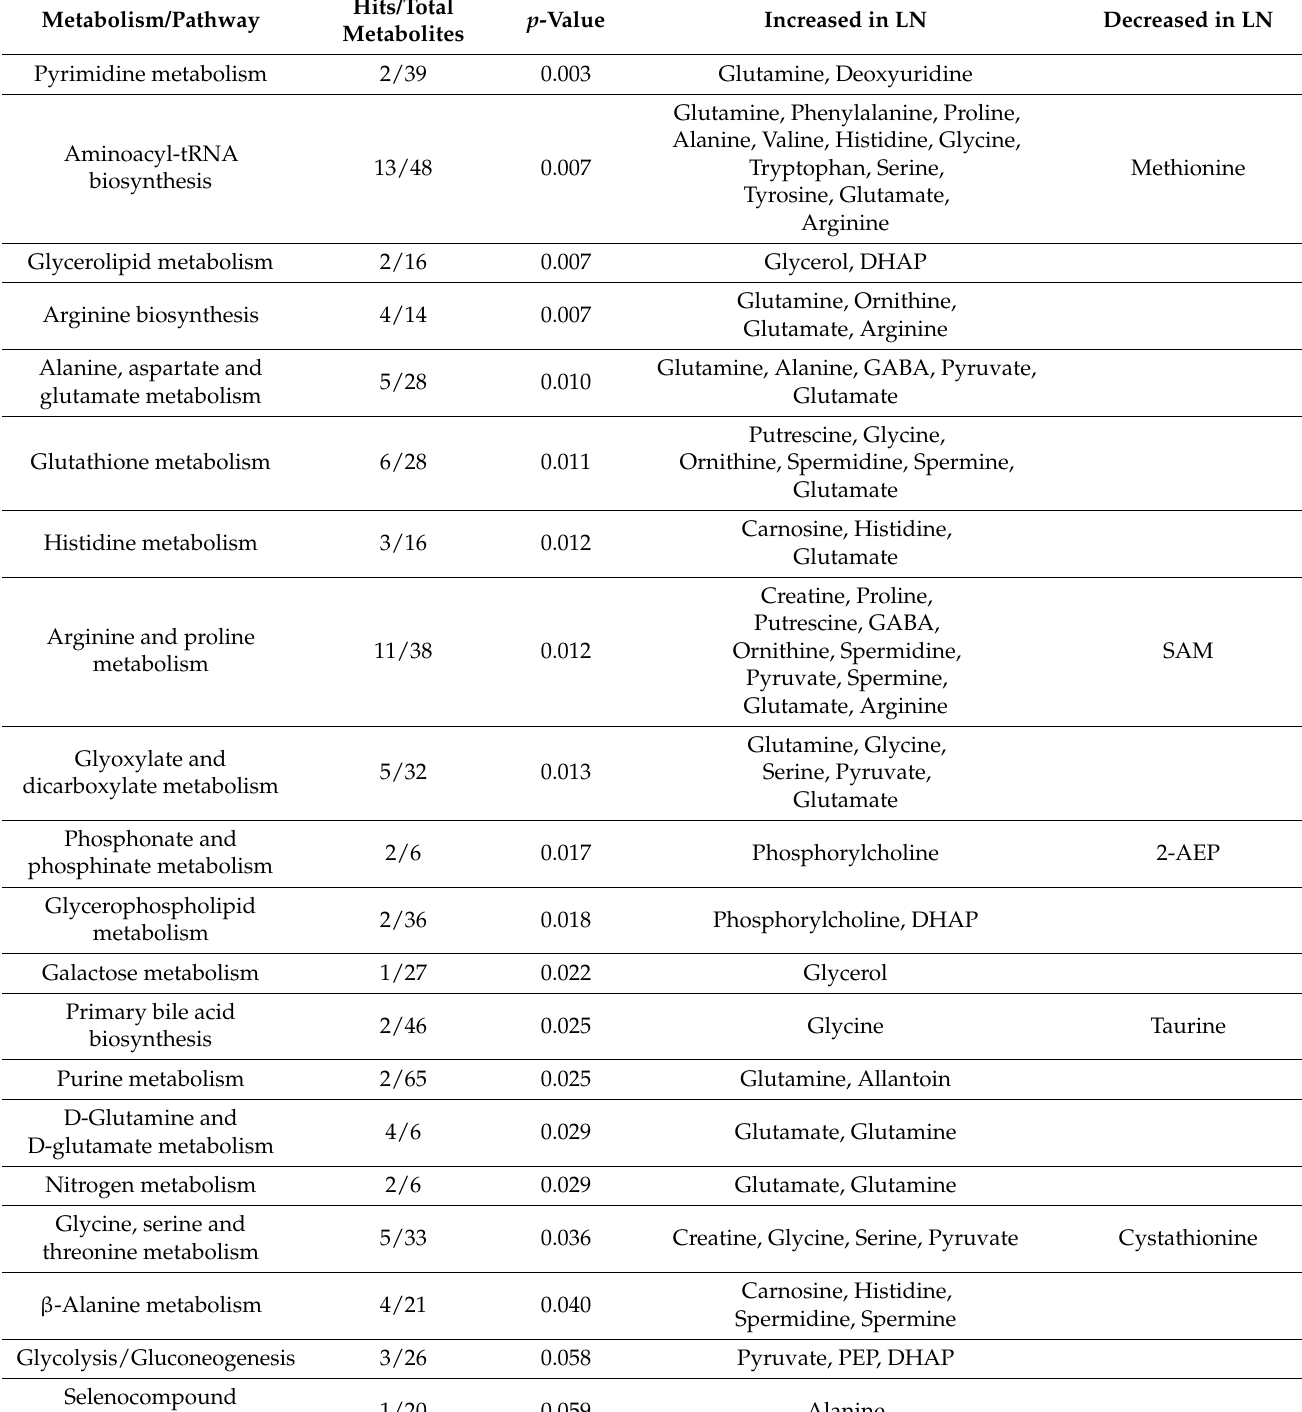
Table 3. Top 20 fetal muscle metabolisms different between LN and HN fetuses